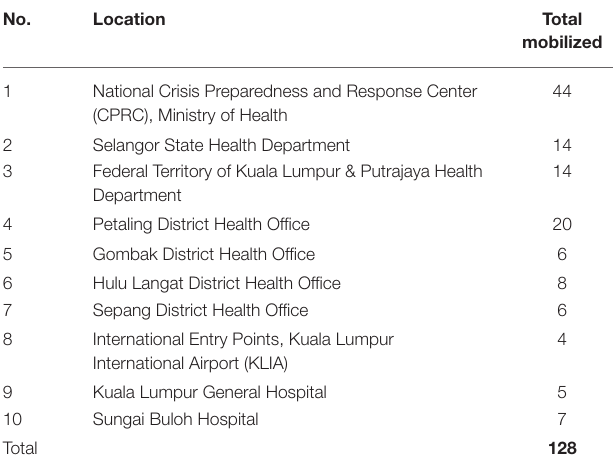
TABLE 2 | Location and the total number of mobilized personnel from the National Institutes of Health